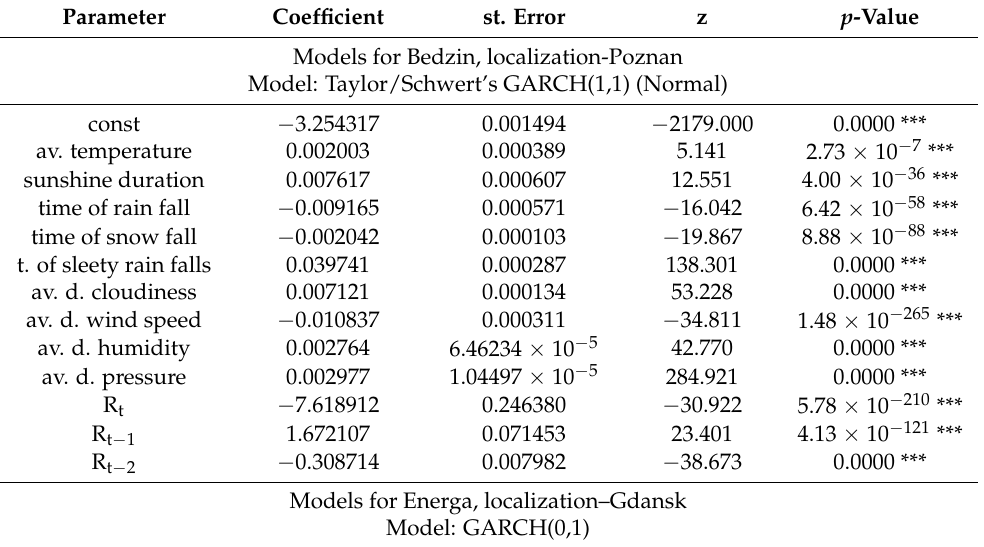
Table 2. Parameter values and a significance level of independent variables for individual companies (dependent variable: Change of